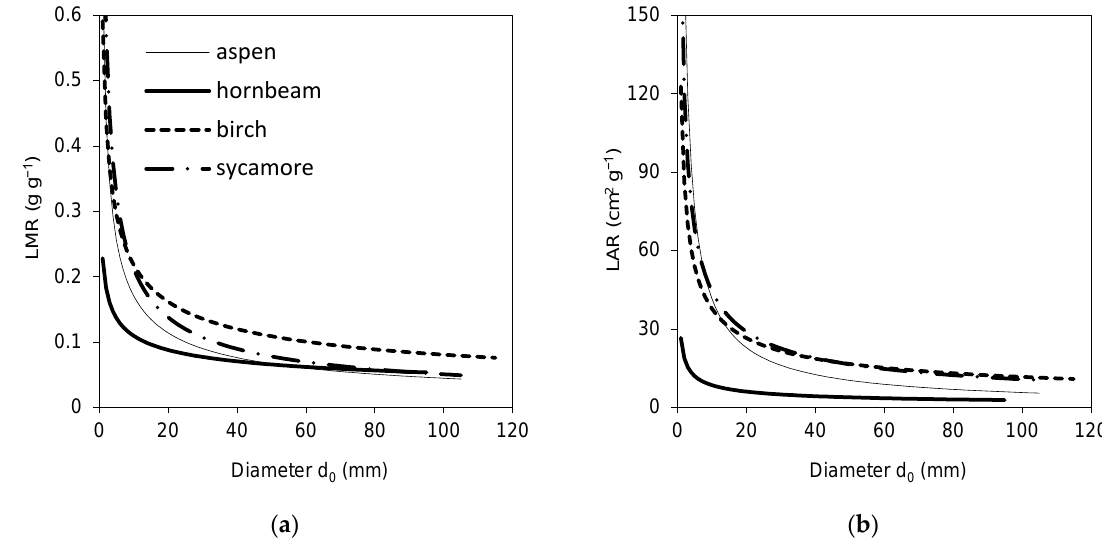
Figure 4. Species-specific models for leaf mass ratio (LMR) ( a ) and leaf area ratio (LAR) ( b ) against diameter d 0 (see Table 5 for Equation (1) parameters and statistical characteristics).